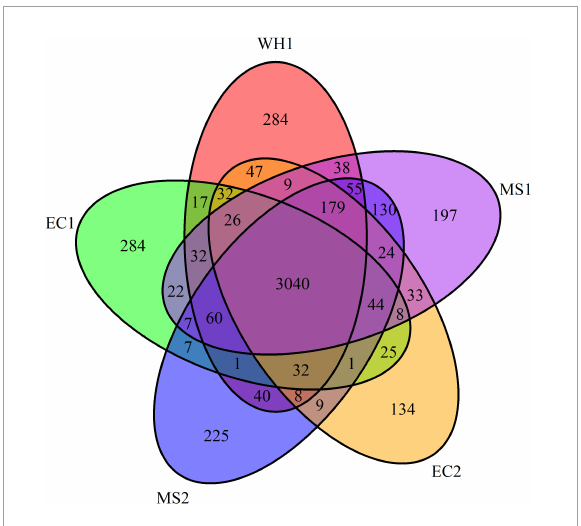
FIGURE3 Venn diagram representing the numbers of common or specific gene clusters among analyzed Dickeya zeae strains in PGAP